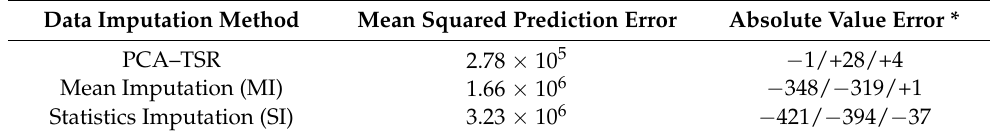
Table 4. The comparison of data imputation